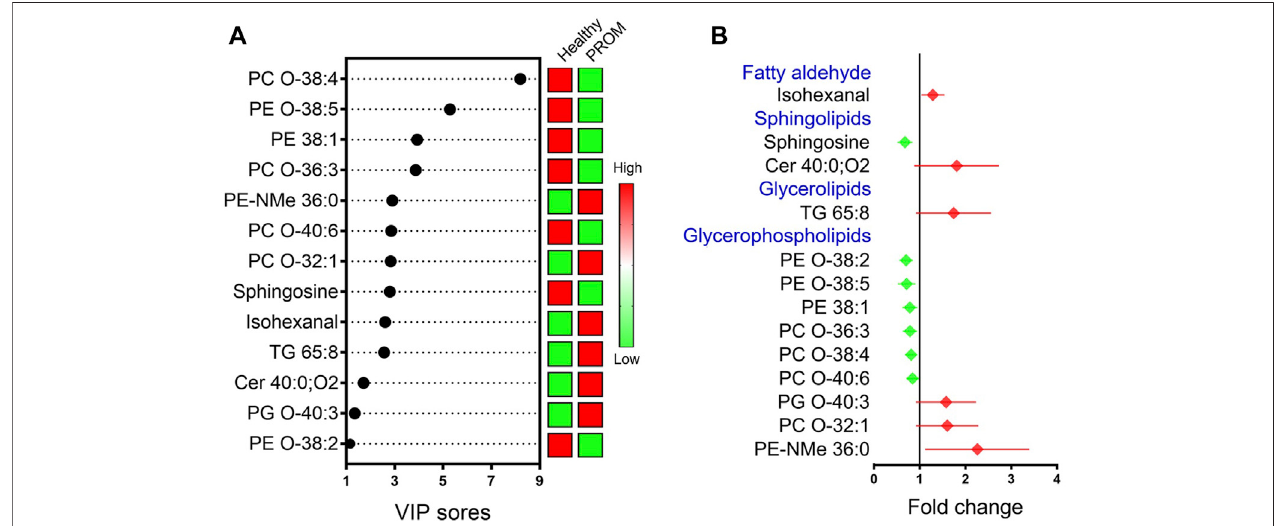
FIGURE 3 | VIP values (A) and mean change (means with 95% con fi dence intervals) (B) in differential metabolic measures with VIP > 1 and p < 0.05 in pregnant women diagnosed with PROM compared with healthy pregnant women. The red symbols indicate that the fold change of the particular metabolite in the PROM cohort were upregulated (fold change > 1); green symbols (fold change < 1) represent downregulated metabolites.